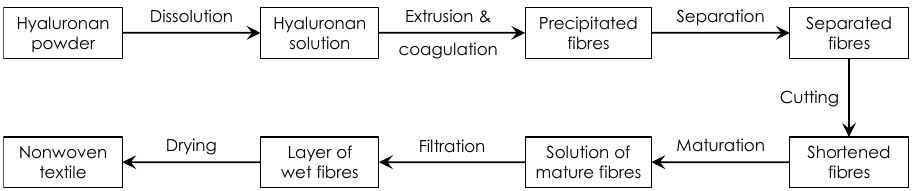
Figure 1. The polymer solution was prepared by dissolving HA in demineralized water